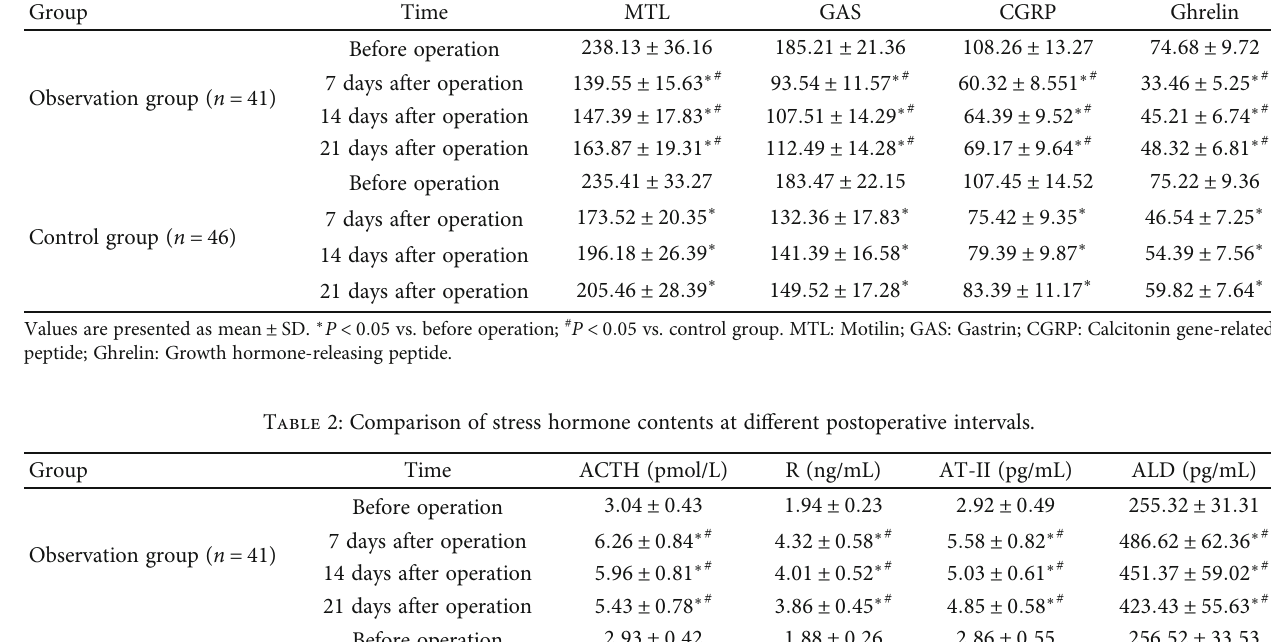
Table 1: Comparison of gastrointestinal hormone contents at di ff erent postoperative intervals (pg/mL). Group Time MTL GAS CGRP Ghrelin Observation group ( n = 41 )